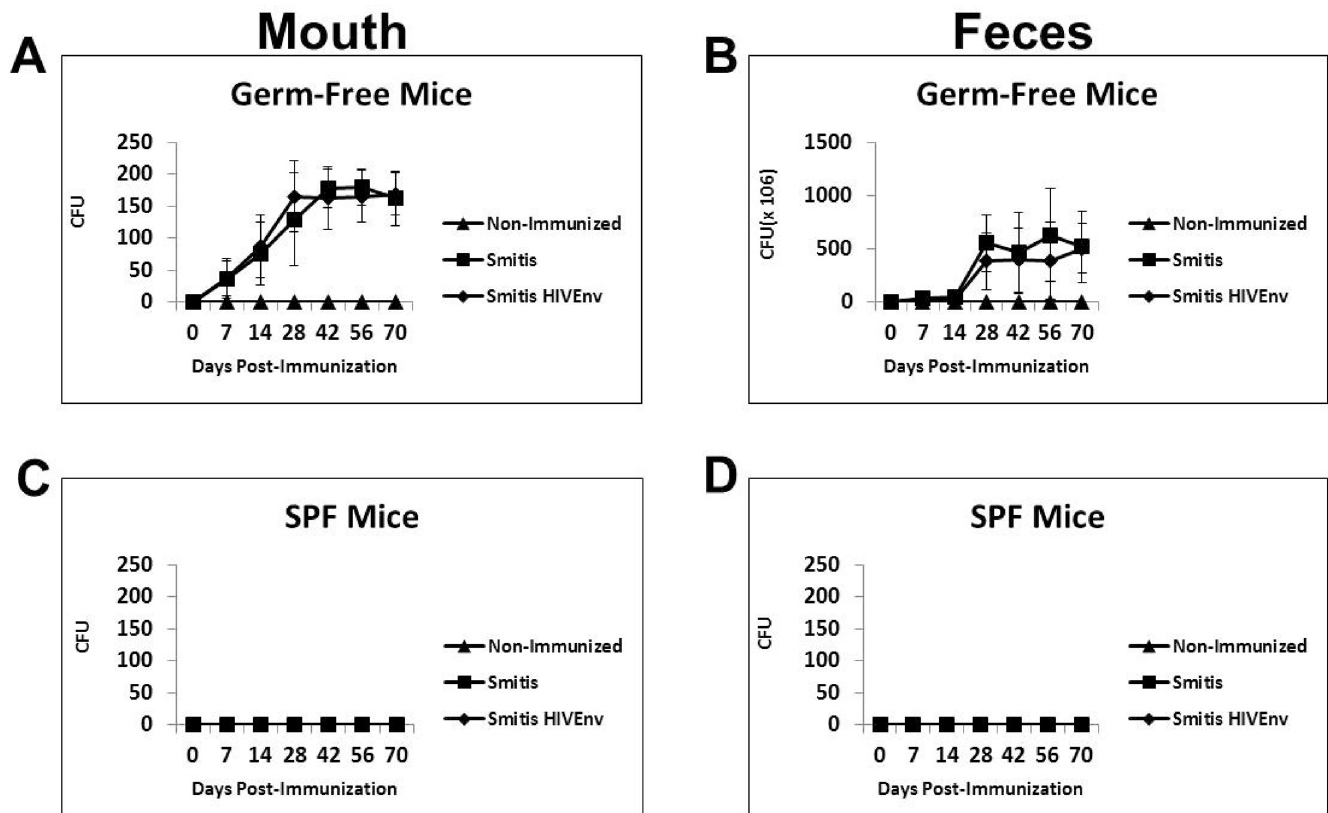
Fig 4. Recombinant S . mitis colonizes germ-free mice efficiently and persistently. Germ-free Balb/c mice and conventional SPF mice were inoculated orally with 10 9 cfu rS . mitis expressing HIV Env gp120 (Smitis HIV Env), rS . mitis containing an integrated Erm r gene without Env (Smitis) or PBS (Non- Immunized). Following inoculation the upper right buccal cheek was swabbed and two pellets of feces were collected from each mouse at various time points. rS . mitis colonization was assessed by growth on THB plates containing 50 μ g/ml erythromycin. The mean colony-forming-units, cfu ( ± SEM) from 3 mice/group at various timepoints, present in the mouth (A) and feces (B) of germ-free mice and in the mouth (C) and feces (D) of conventional mice inoculated with rS . mitis are shown.